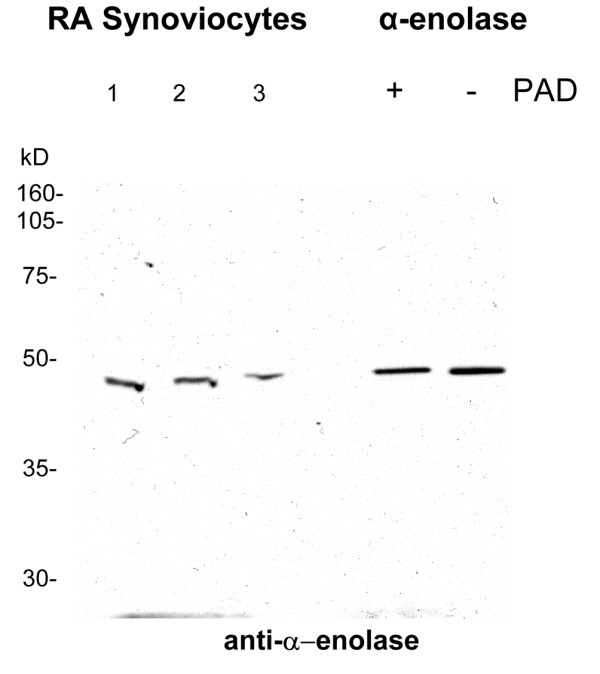
Presence of α-enolase in synovial cells from patients with rheumatoid arthritis (RA). Immunoblotting of lysates from RA synovial cells with anti-α-enolase (+PAD, deiminated α-enolase; – PAD, undeiminated α-enolase) showing a 47 kDa protein in synoviocytes, from three patients with RA, reacting with the goat anti-α-enolase antibody, which co-migrates with purified α-enolase.